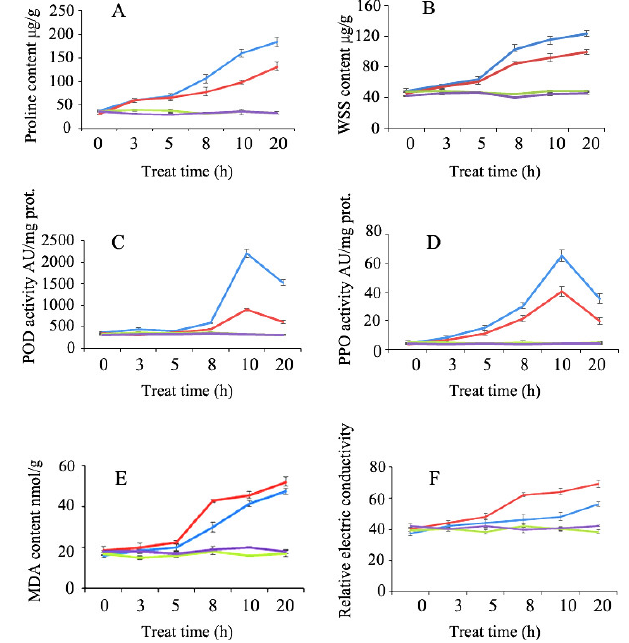
Figure 2. Physiological and biochemical characters of two Ae. tauschii (XJ002 and XJ098) with contrasting drought tolerance. ( A ): Proline content; ( B ): WSS content; ( C ): POD activity; ( D ): PPO activity; ( E ): MDA content; ( F ): Relative electrolyte conductivity. Blue line: XJ002_treatment; Red line: XJ098_treatment; Green line: XJ002_control; Purple line: XJ098_contorl.